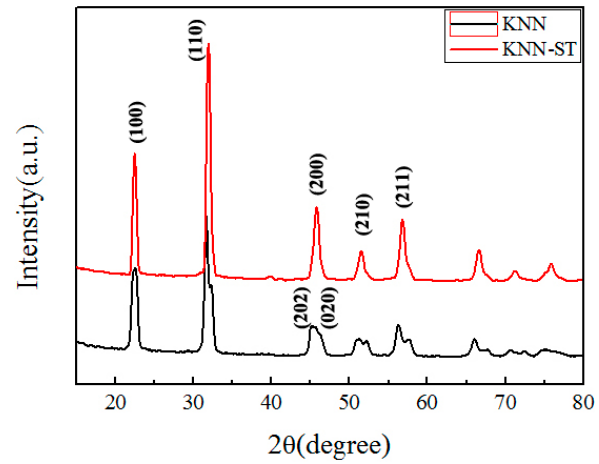
Figure 2. XRD patterns of the K 0.5 Na 0.5 NbO 3 (KNN) and the (K 0.5 Na 0.5 NbO 3 )-0.15SrTiO 3 (KNN-ST) particles.